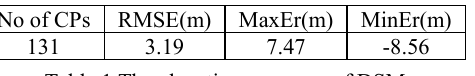
DOMsChecking points Planar